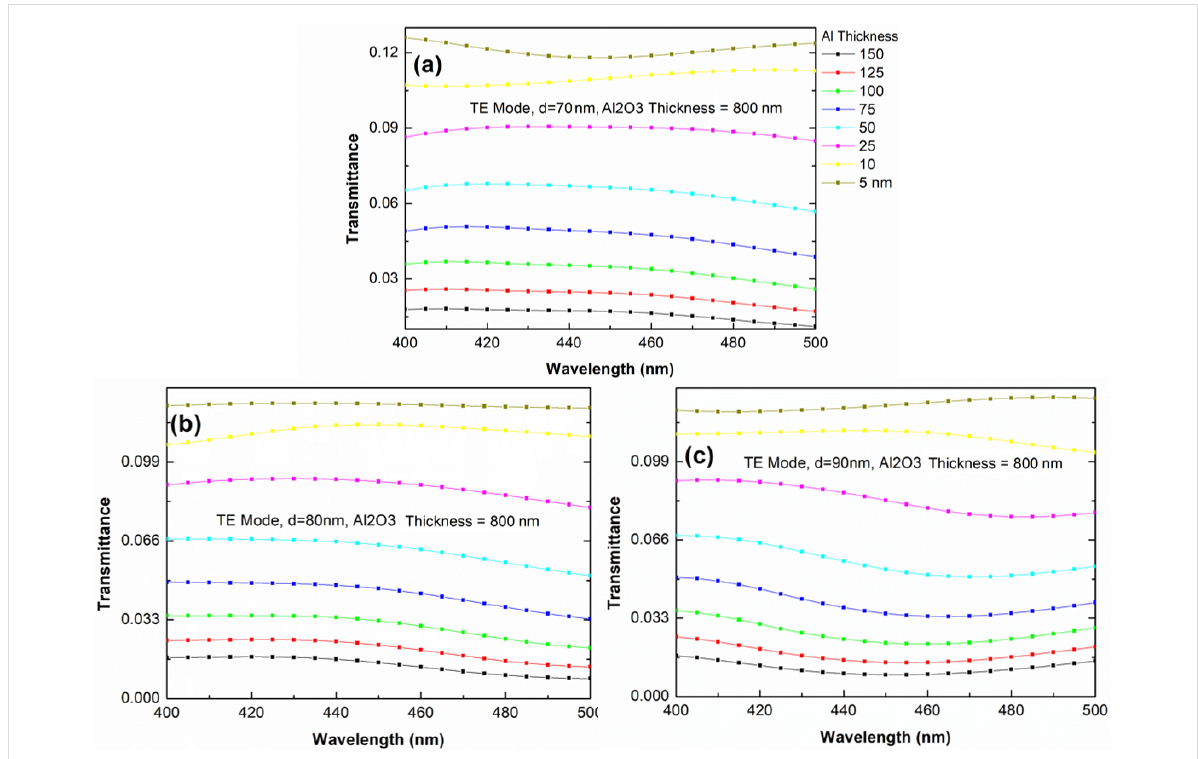
Figure 11: Rigorous coupled-wave analysis (RCWA) results with different Al thickness values and fixed Al 2 O 3 thickness of 800 nm for samples (a) AAO60 (b) AAO70 and (c)